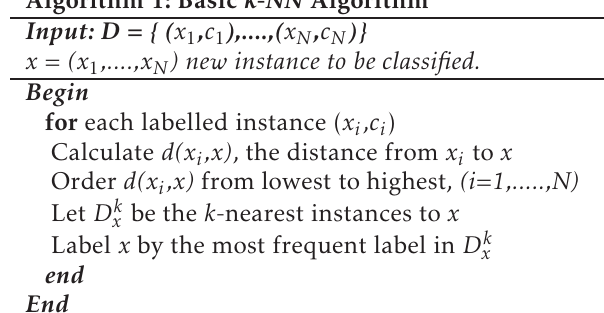
Figure 3. Taxonomy of Anomaly Detection Techniques Algorithm 1: Basic k-NN